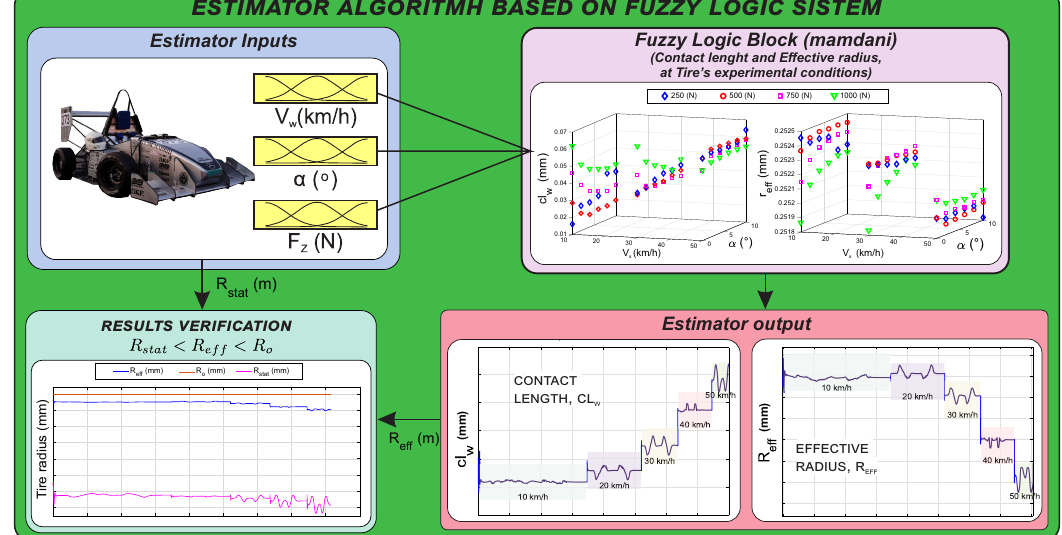
Figure 15. Algorithm of the development of the fuzzy logic estimator.